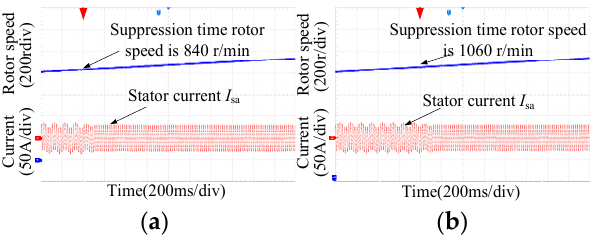
Figure 21. The SSO inhibition effect at different speeds: ( a ) sub-synchronous speed; ( b ) su- per-synchronous speed.